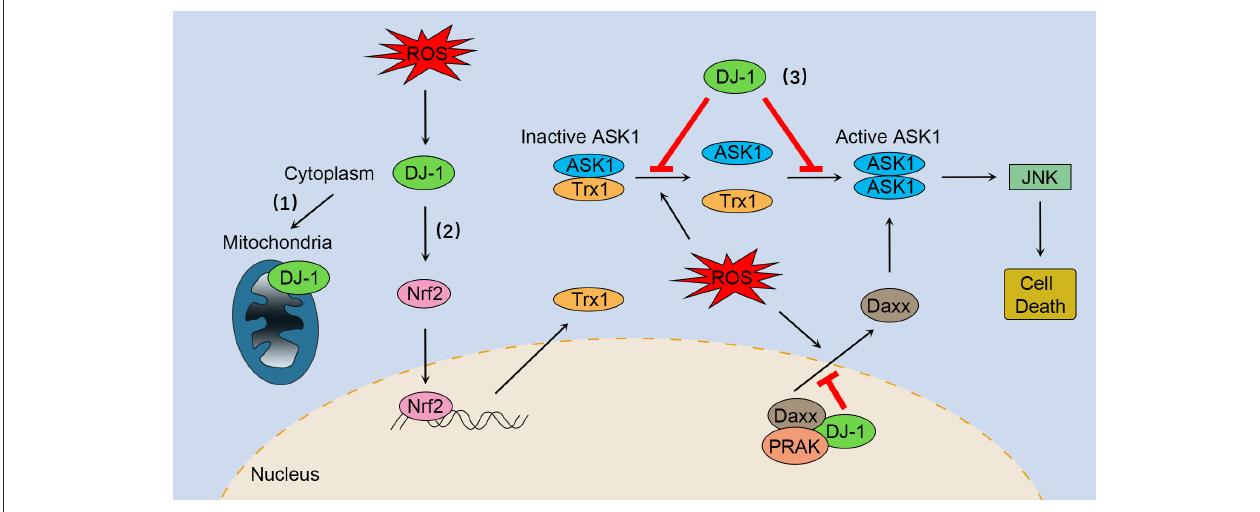
FIGURE 1 | The multifaceted roles of DJ-1 as an antioxidant under oxidative stress. (1) DJ-1 translocates to the mitochondria and maintains mitochondrial homeostasis. (2) DJ-1 exerts antioxidant function by upregulating Nrf2 activation. (3) DJ-1 prevents oxidative stress-induced ASK1 signaling pathways by several mechanisms, including stabilizing the Trx1–ASK1 complex, increasing the expression of Trx1, disrupting ASK1 homodimerization through direct interaction, as well as sequestering the ASK1 activator Daxx in the nucleus. Nrf2, NF-E2 related factor-2; ASK1, apoptosis signal-regulating kinase 1; Trx1, thioredoxin 1; Daxx, death-associated protein 6; PRAK, p38-regulated/activated kinase; JNK, c-Jun N-terminal kinase.